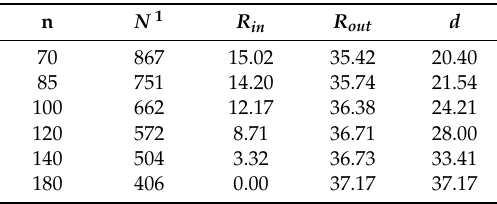
tail length for P n –H with ϕ = 4.4% at T ∗ =